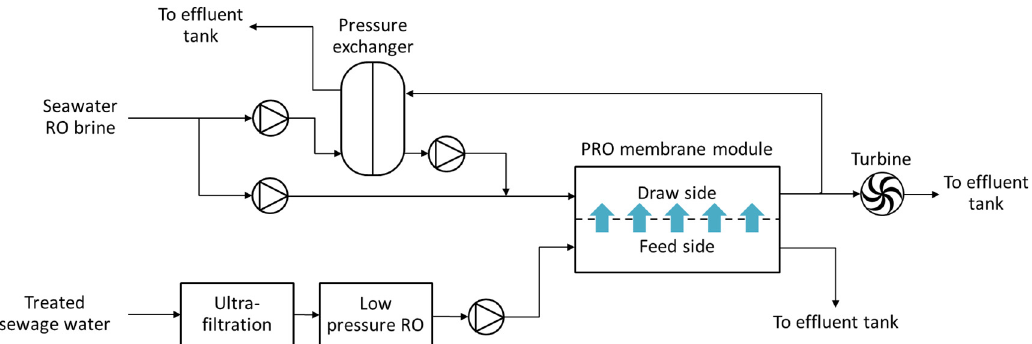
Figure 5. Schematic of the RO-PRO hybrid plant in Japan, adapted from [10].